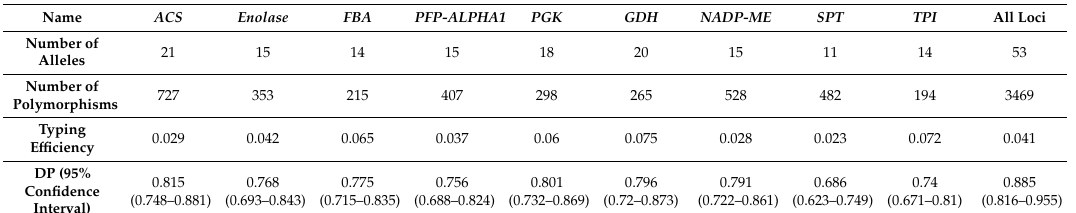
Table 2. Calculation of typing e ffi ciency and discriminatory power of evaluated